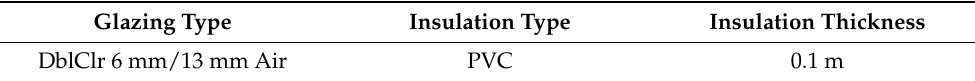
Table 5. The selected measures based on the 2080 weather file.